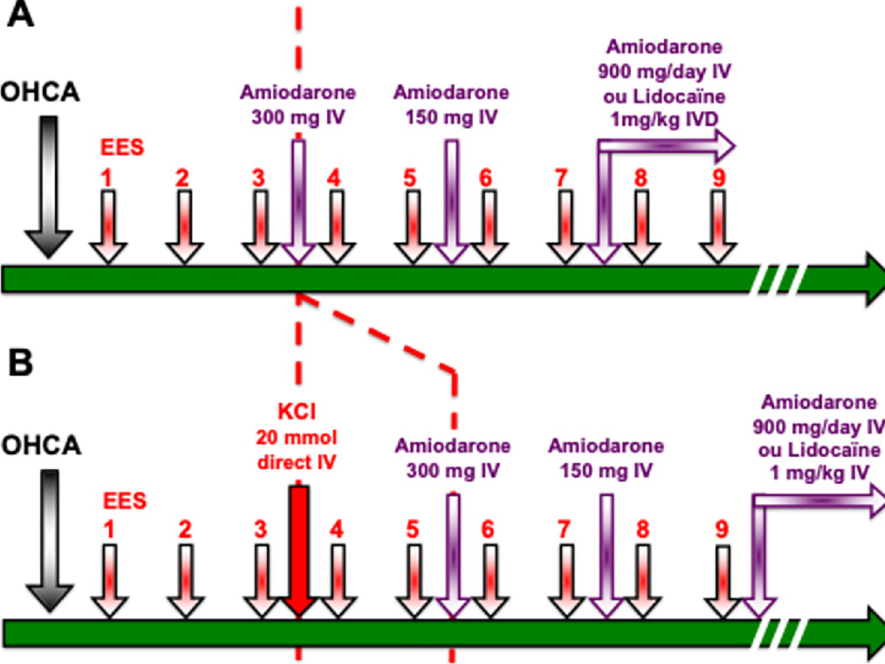
Fig 1. Management algorithm for a patient with out of hospital cardiac arrest (OHCA) by VF according to international recommendations (Fig 1A) and in the context of this research (Fig 1B). Epinephrine injections are not shown in the figure for